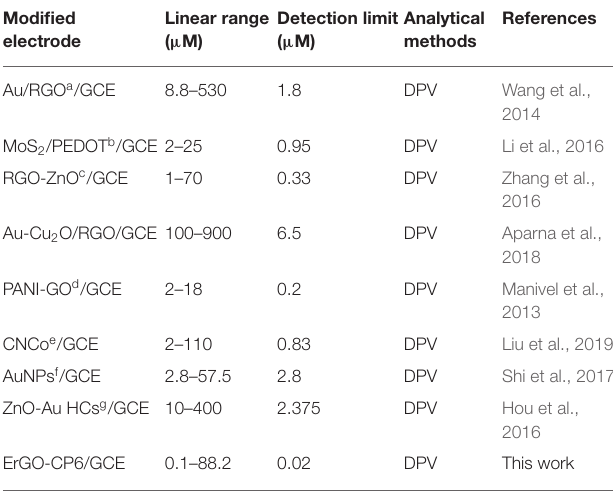
TABLE 1 | Comparison with other modified electrodes in the literatures for the detection of UA.